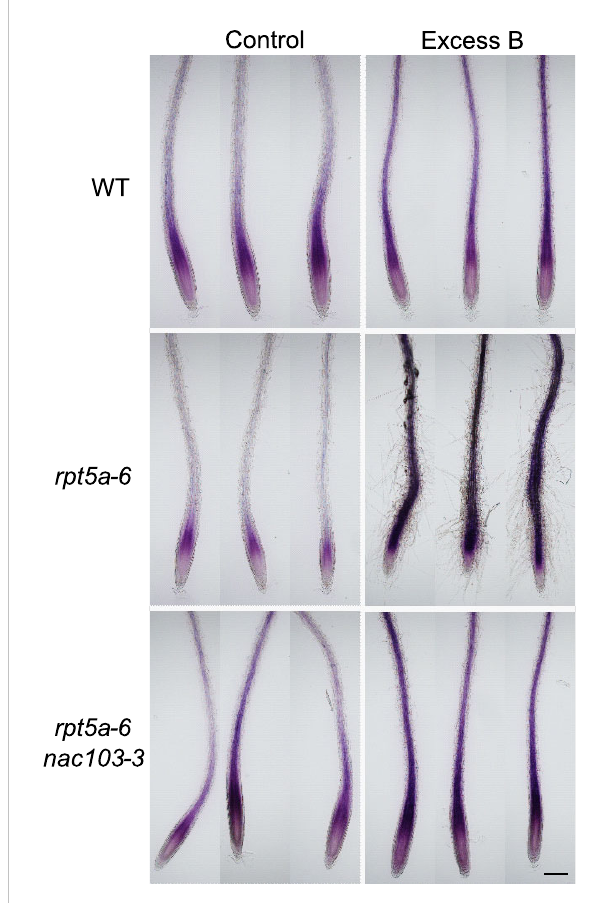
FIGURE 7 Superoxide accumulation in root tips of rpt5a-6 and rpt5a-6 nac103-3. Seedlings were grown for six days under control conditions (30 µM boric acid) and further three days on control or excess boron conditions (3 mM boric acid). Superoxide was observed as purple stain by nitroblue tetrazolium (NBT) staining. Images from three biological replicates are shown. Bar, 200